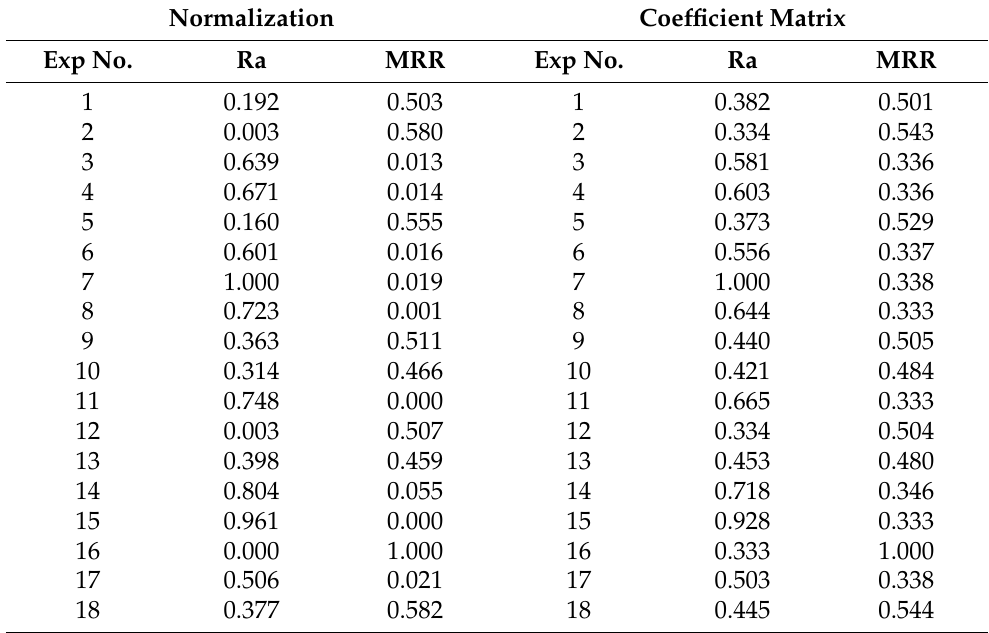
Table 12. Normalization and coefficient matrix values for average surface roughness and